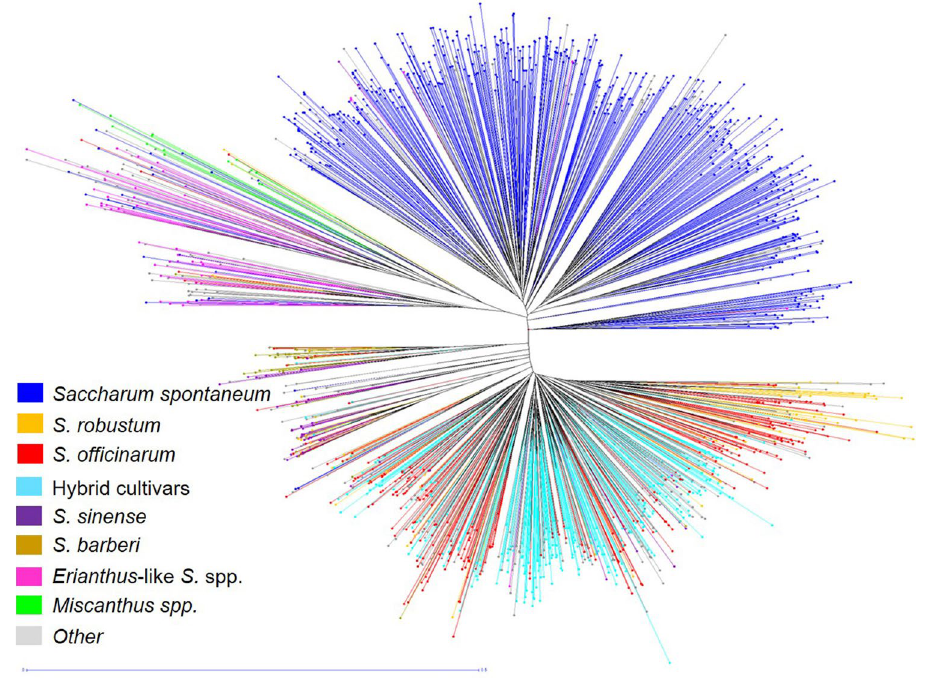
Figure 2. Neighbor-joining tree of the Saccharum complex showing genetic diversity based inter- and intra-species differentiation of 1,485 clones using 423 SSR alleles. Erianthus- like Saccharum spp. included S. arundinaceum , S. bengalense , S. ravennae , S. rufipilum , S. brevibarbe, S. kanashiroi, S. procerum, and unknown species previously identified as Erianthus. Other species included Coix lacryma-jobi, Imperata sp., Sorghum polumosum, Saccharum edule, and unknown.